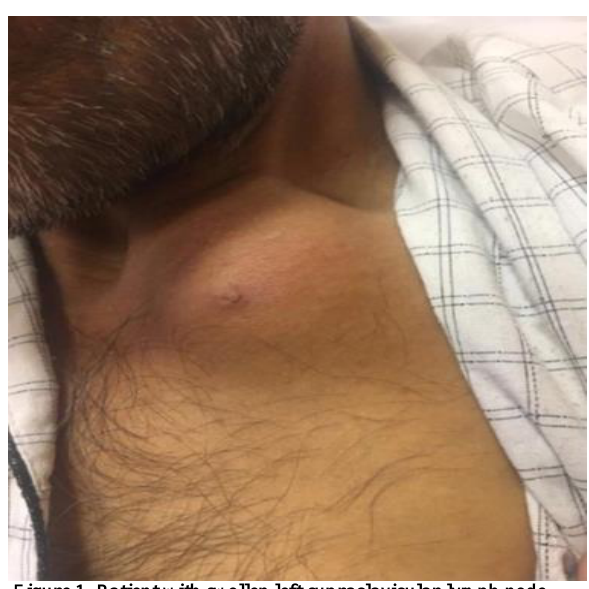
Figure 1- Patient with swollen left supraclavicular lymph node. Regarding the signs and symptoms of infection of the node, the first differential diagnosis was the node's abscess. Colonoscopy of the sigmoid colon revealed an infiltrative and ulcerative tumor in favor of colon